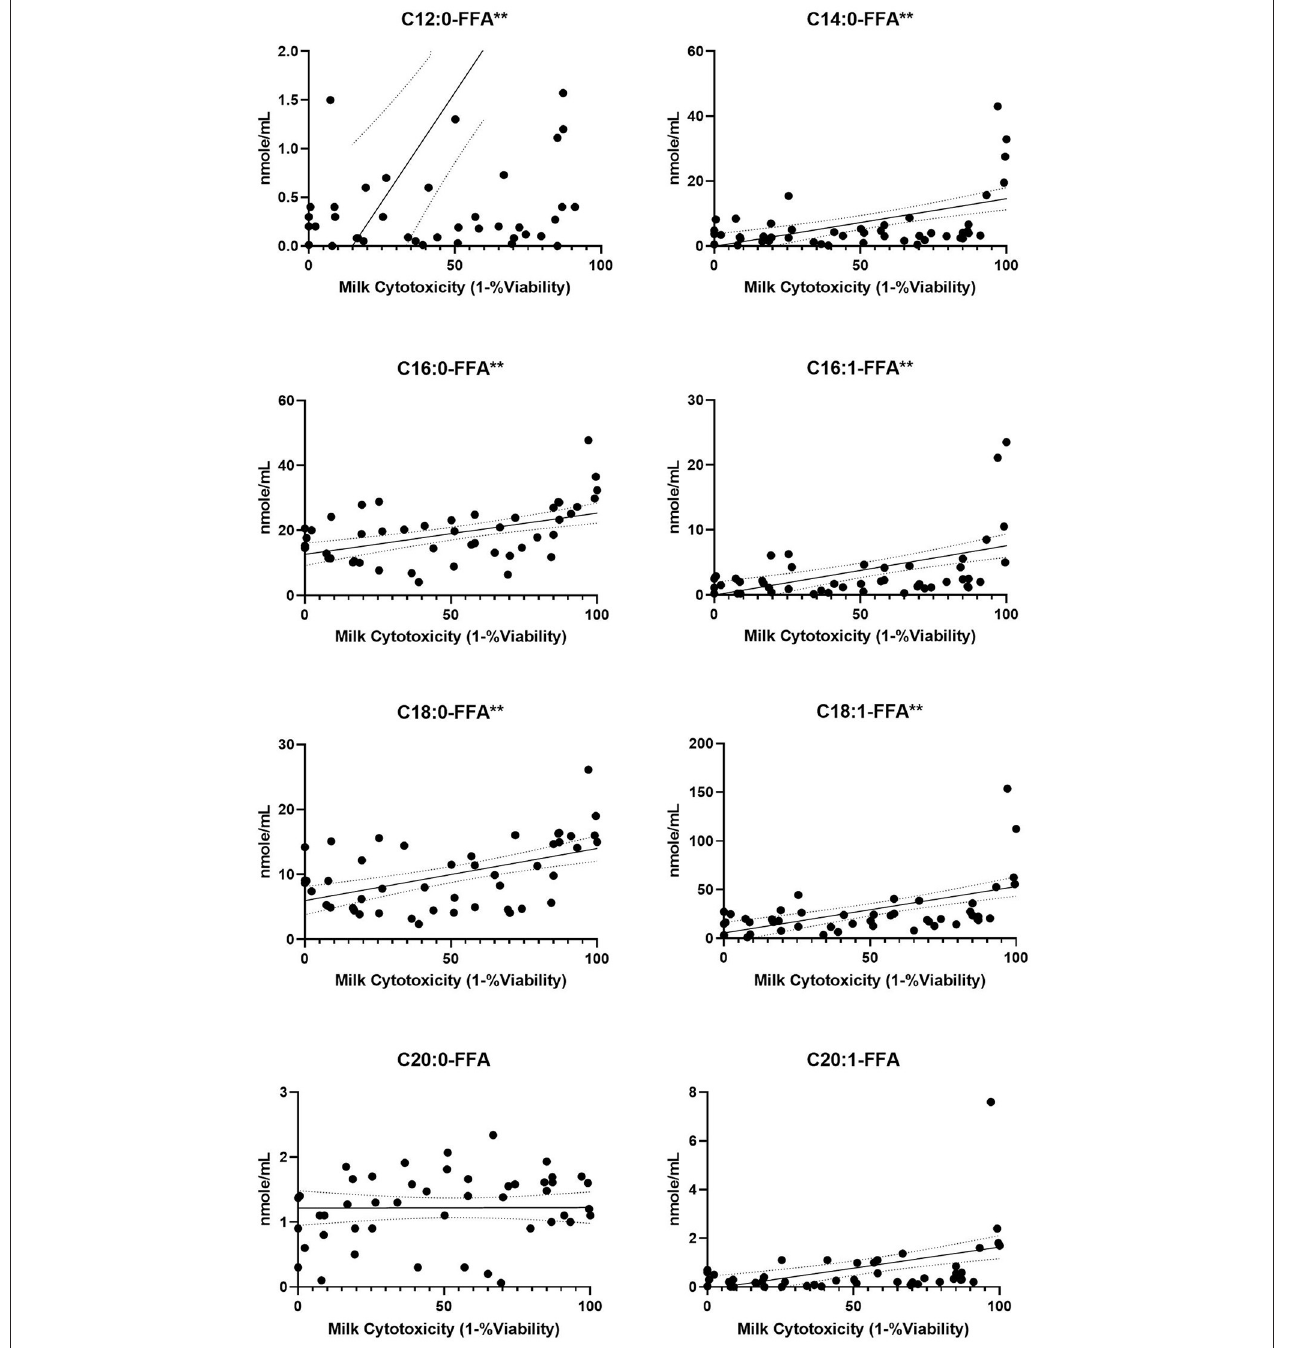
FIGURE 4 | FFA content from human milk fractions increases with cytotoxicity. Previously frozen preterm skimmed ( n = 34), casein ( n = 11) and whey ( n = 11) milk samples were tested at 10% concentrations for intestinal cell viability, then 15 FFA species were quantified by UHPLC-MS/MS. The 8 species shown had concentrations > 1 nmol/mL. Simple regression slopes with 95% confidence intervals are shown. Significance noted as ** p < 0.0001. FFA, free fatty acids; UHPLC, ultra high performance liquid chromatography; MS, mass spectrometry.